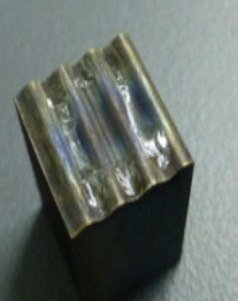
Figure 15. Glass stuck on the pressing die ( left ) and seriously ruptured MLA ( right ) when using the pressing die with a surface roughness of 0.2 µm Ra.